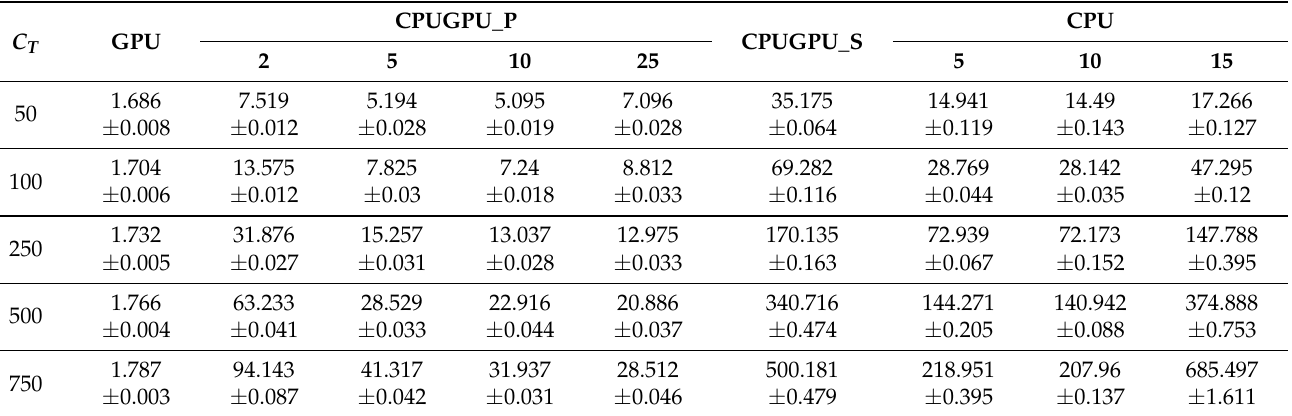
Table 2. Effect of number of observations on computation time. Results of experiments for constant action without DNN model ( C S =